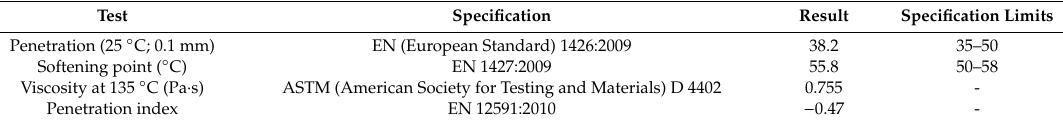
Table 2. Properties of the bitumen.